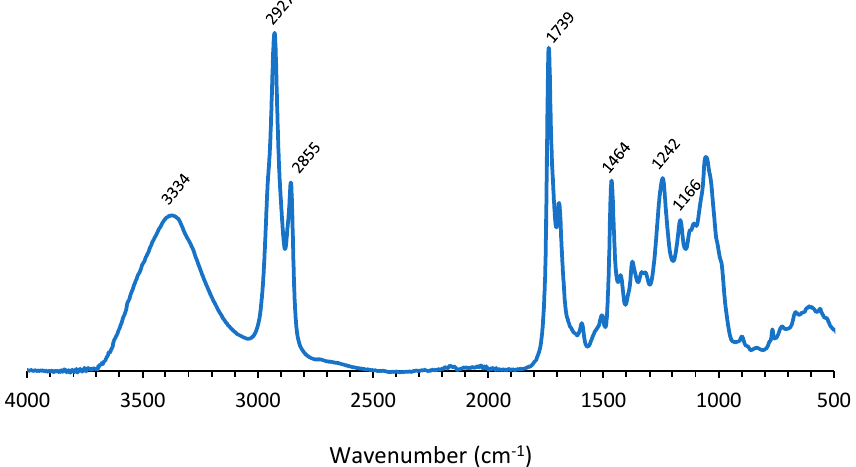
Figure 5. IR spectrum of degradation product insoluble in aqueous phase (recycled polyol).